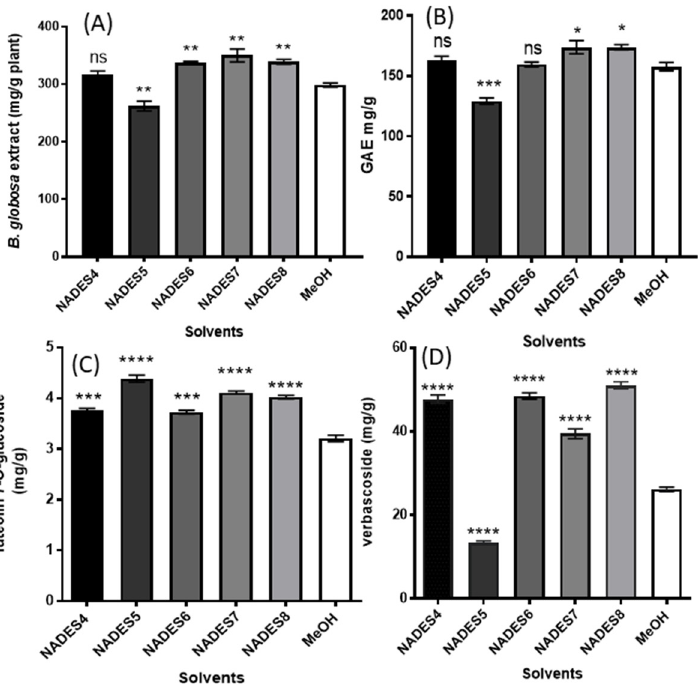
Figure 7. Effect of different NADESs on the extraction yields of B. globosa ( A ); Total Polyphenols ( B ); 7- O -glucoside ( C ), and verbascoside ( D ) from Buddleja globosa leaves. Data correspond to the means ± SD (n = 3). There is a significant difference when * p < 0.05; ** p < 0.01; *** p < 0.001 or **** p < 0.0001 versus 80% methanol. Abreviation: ns: not significant.